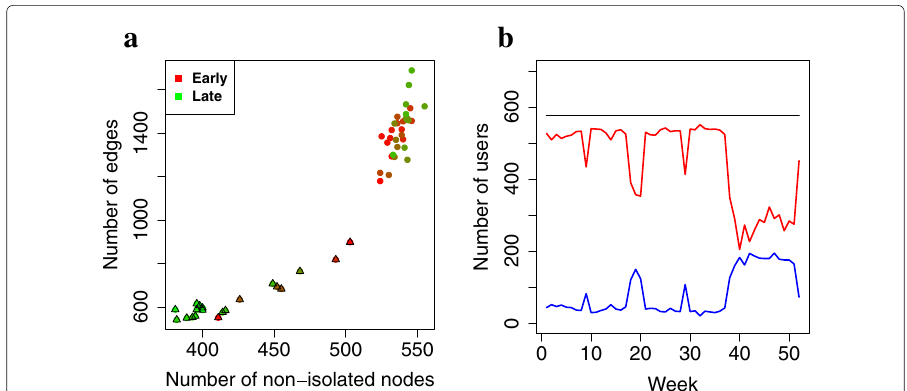
Fig. 2 Network size statistics. a The number of non-isolated nodes and edges in each snapshot. Dots represent network snapshots of school weeks. Triangles represent network snapshots of break weeks. The color shifts from red to green as time goes from the first week (early) to the last week (late). b Some statistics about the connectivity of the dynamic network. The red line shows the number of nodes in the largest connected component (LCC) in each week. The blue line shows the number of isolated nodes in each week (i.e., users that have no links in the given week and are thus absent from that week’s network snapshot). The black line shows the maximum possible number of non-isolated nodes in each week, i.e., the total number of considered users (the size of